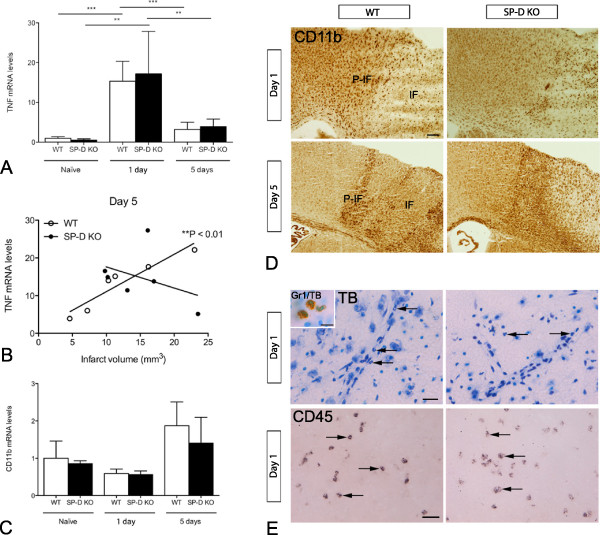
Changes in inflammatory profile between surfactant protein-D (SP-D) knock out (KO) and wild type (WT) mice after permanent middle cerebral artery occlusion (pMCAO). (A) No differences were observed in TNF mRNA levels between naïve SP-D KO and WT mice nor between SP-D KO and WT at 24 hours or 5 days after pMCAO. Both genotypes showed a significant increase in TNF mRNA levels at 24 hours compared to naïve and 5 days (one-way ANOVA followed by Tukey’s multiple comparison test, n = 5 to 8). (B) TNF mRNA levels correlated with the infarct volume in WT mice 5 days after pMCAO (Spearman’s r = 0.99), a correlation which was not present in SP-D KO mice. (C) No difference was observed in CD11b mRNA levels between naïve SP-D KO and WT mice or at 24 hours or 5 days. (D) Immunohistochemical staining for CD11b at 1 day and 5 days after pMCAO showed similar microglial-leukocyte activation in SP-D KO and WT mice. (E) No difference was observed in PMN infiltration assessed by nuclear morphology in toluidine blue-stained sections, or infiltration with CD45+ cells between SP-D and WT at 24 hours. Insert: immunohistochemical demonstration of Gr1 by PMN. IF: infarct, P-IF: peri-infarct. Scale bars: D = 200 μm, E = 40 μm, insert = 10 μm. **P < 0.01; ***P < 0.001.